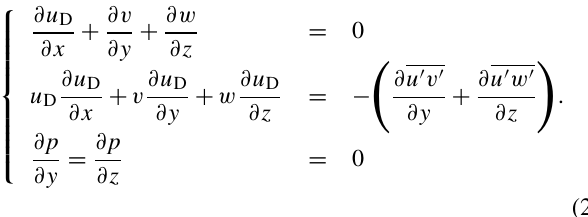
wakes or wakes aligned on the same axis as those illus- trated in Fig. 1a can be simulated with such models. For the case of wake–turbine or wake–wake interaction, shown in Fig. 1b and c, pragmatic methods are required. In the kine- matic model by Katic et al. (1986), the square addition of the individual wake deficits is applied to deal with multiple wakes. In a previous study, Lissaman (1979) proposed the linear addition of the deficits; however, this method tends to overestimate the velocity reduction and could lead to unreal- istic flow reversal when many wakes